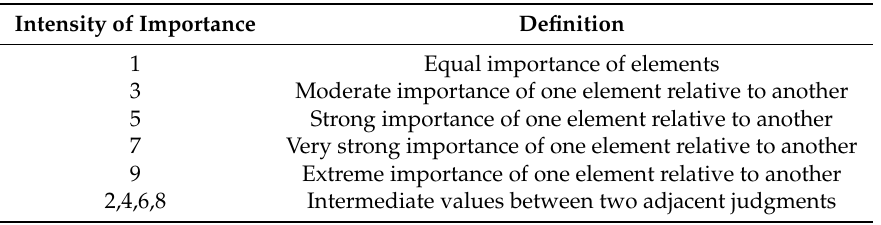
Table 2. Pairwise comparison